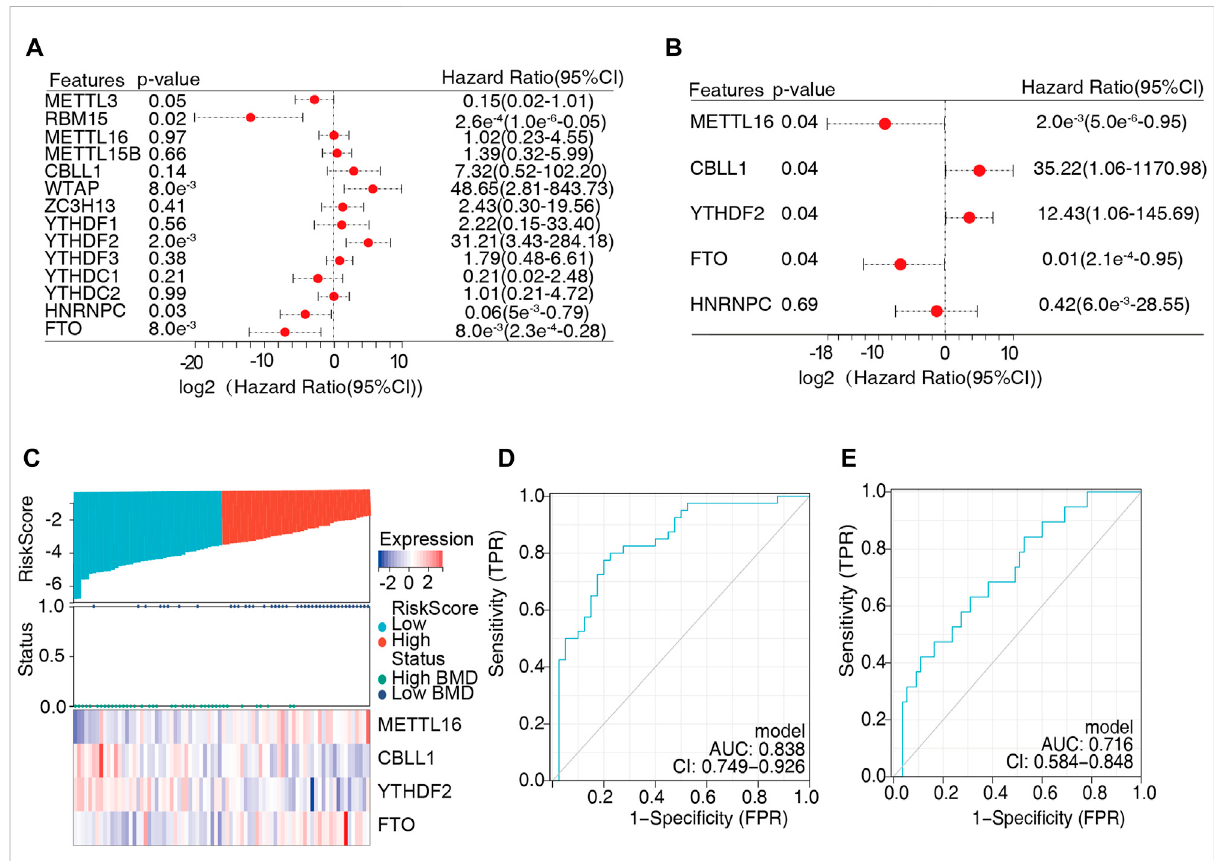
Construction of a diagnostic model of osteoporosis. (A) Univariate logistic regression analysis was conducted to identify the critical m6A regulators, indicating that fi ve m6A regulators were signi fi cant for osteoporosis ( METTL16 , CBLL1 , YTHDF2 , HNRNPC , and FTO ). (B) Multivariate logistic regression was employed to identify the independent modules, and four vital m6A regulators were obtained for the diagnostic model ( METTL16 , CBLL1 , YTHDF2 ,and FTO ). (C) Theriskscorewascalculatedbasedontheexpressionofthefourvitalm6Aregulators,andthemedian risk score ( – 0.366) was used as the cutoff point. All samples were divided into two groups: the high-risk group and the low-risk group. (D,E) The sensitivity and speci fi city of the diagnostic model in the training dataset (D) and test dataset (E) were determined by receiver operating characteristic (ROC) curves, and the area under the curve was